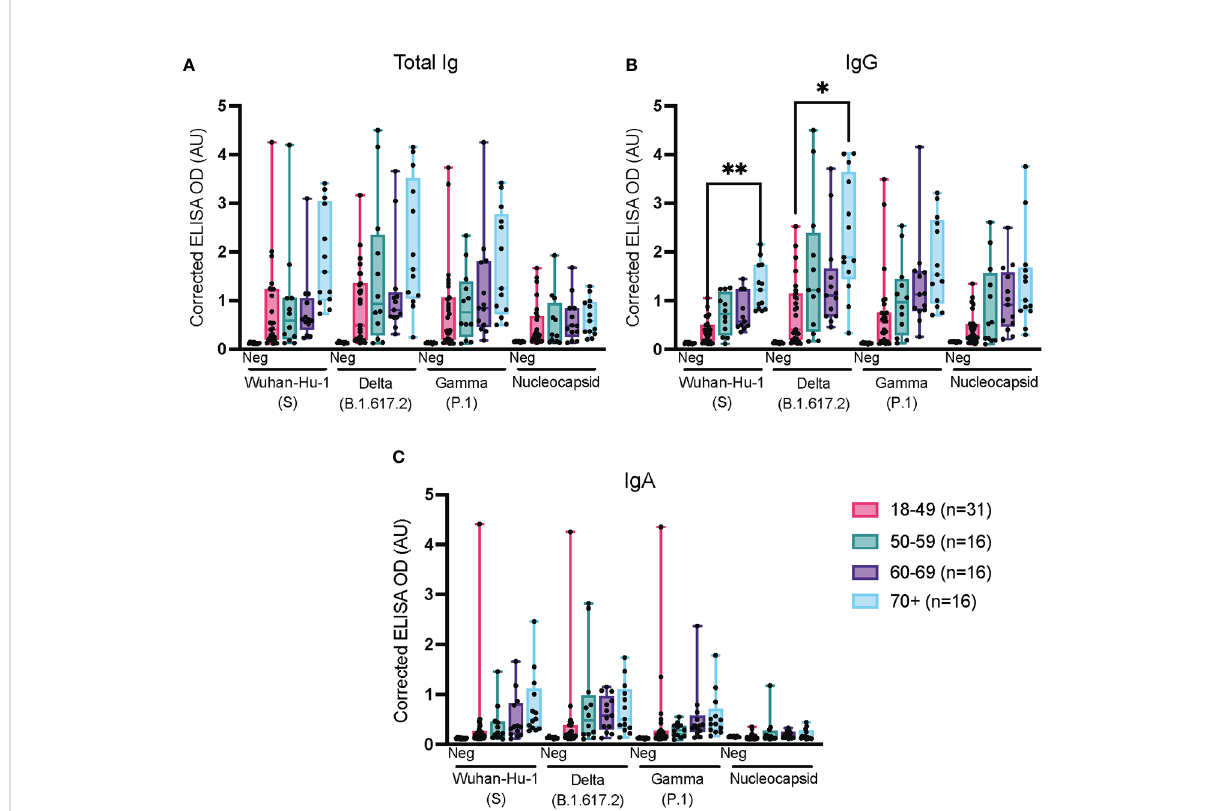
FIGURE 6 Impact of age on the immune response against spike and nucleocapsid antigens. ELISAs for total Ig, IgG and IgA were conducted at the UdeM site using the serum samples from Figure 3, week 8. The 65 con fi rmed SARS-CoV-2-positive individuals were grouped as: 18-49 years of age (n=27); 50-59 (n=12); 60-69 (n=13) and 70+ years of age (n=13). Post-vaccination samples were excluded. The secondary antibodies used are listed in Table 2. The average of triplicate assays is given as D OD 450-595 (corrected OD). The average of triplicate assays is given as corrected OD. The median is shown in the quartile boxplots where the whiskers include all values (no outliers excluded). Negative controls (Neg) using serum from 8 COVID-negative individuals are shown as the average of triplicate assays. *p < 0.05 ** p <